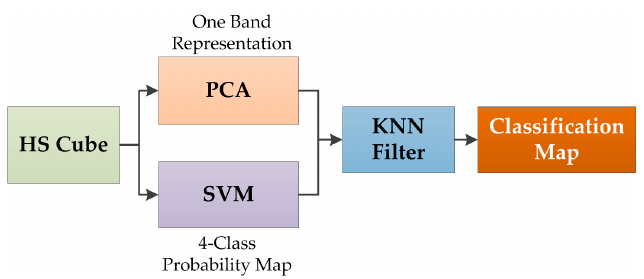
Figure 4. Block diagram of the spatial–spectral supervised algorithm pipeline.